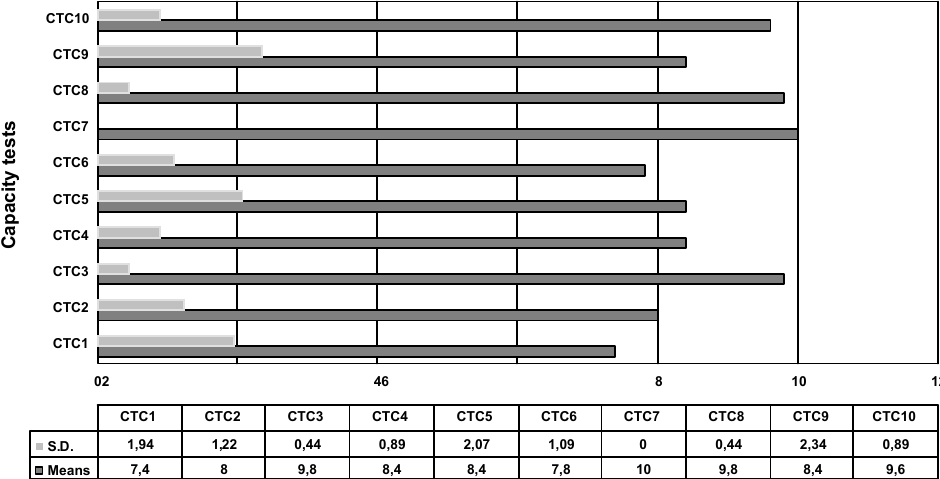
Figure 3. Self-assessment test scores The student sample consisted of 78 undergraduate students from a variety of disciplines from the two Canary Island universities. The first index of validity was scale reliability. Estimates of the internal consistency of the actual and preferred forms of each AUTAQ scale were calculated using Cronbach’s alpha coefficient.